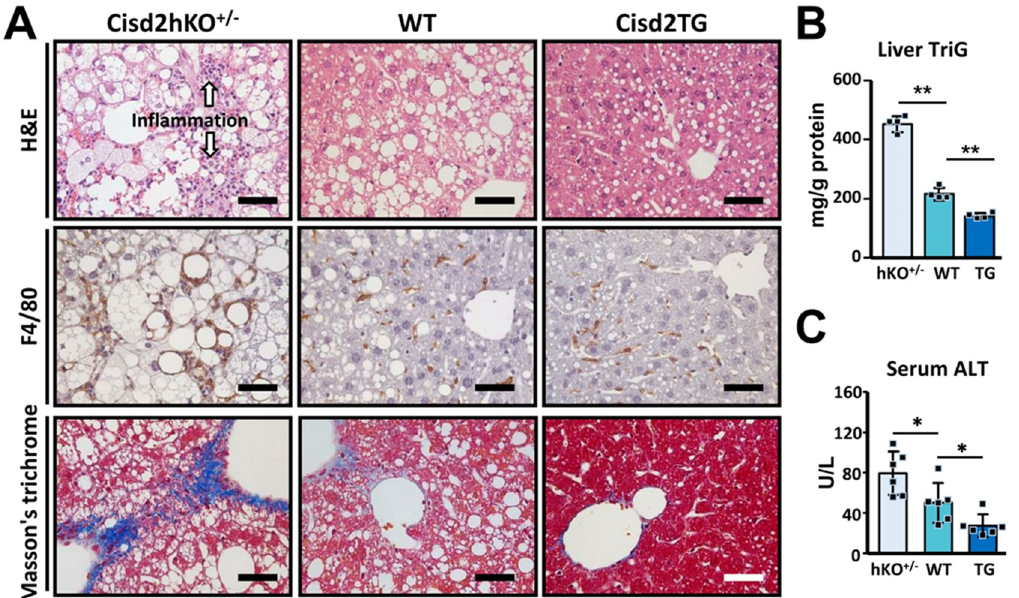
Figure 2. Cisd2 modulates WD-induced nonalcoholic fatty liver disease (NAFLD) and nonalcoholic steatohepatitis (NASH) in a dose-dependent manner. ( A ) Representative images of H&E, IHC staining of F4/80 (Kupffer cell marker) and Masson’s trichrome staining of liver sections prepared from WD-fed mice at 6-month-old. Hepatic steatosis, hepatocyte ballooning, and degeneration, as well as overt inflammation are detected in the livers of Cisd2hKO +/ − mice. ( B ) Liver triglyceride levels ( n = 4). ( C ) Serum ALT levels ( n = 6). Scale bar, 50 µ m. Data are presented as mean ± SD. * p < 0.05; ** p < 0.005.